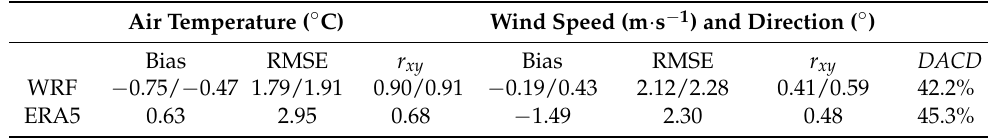
Table 4. Validation statistics for air temperature, wind speed and direction from the WRF simulations and the ERA5 reanalysis for the summer period on Davies Dome. For WRF, an interval including all boundary layer (BL) schemes is presented. Wind direction accuracy is shown as the directional accuracy of circular distance